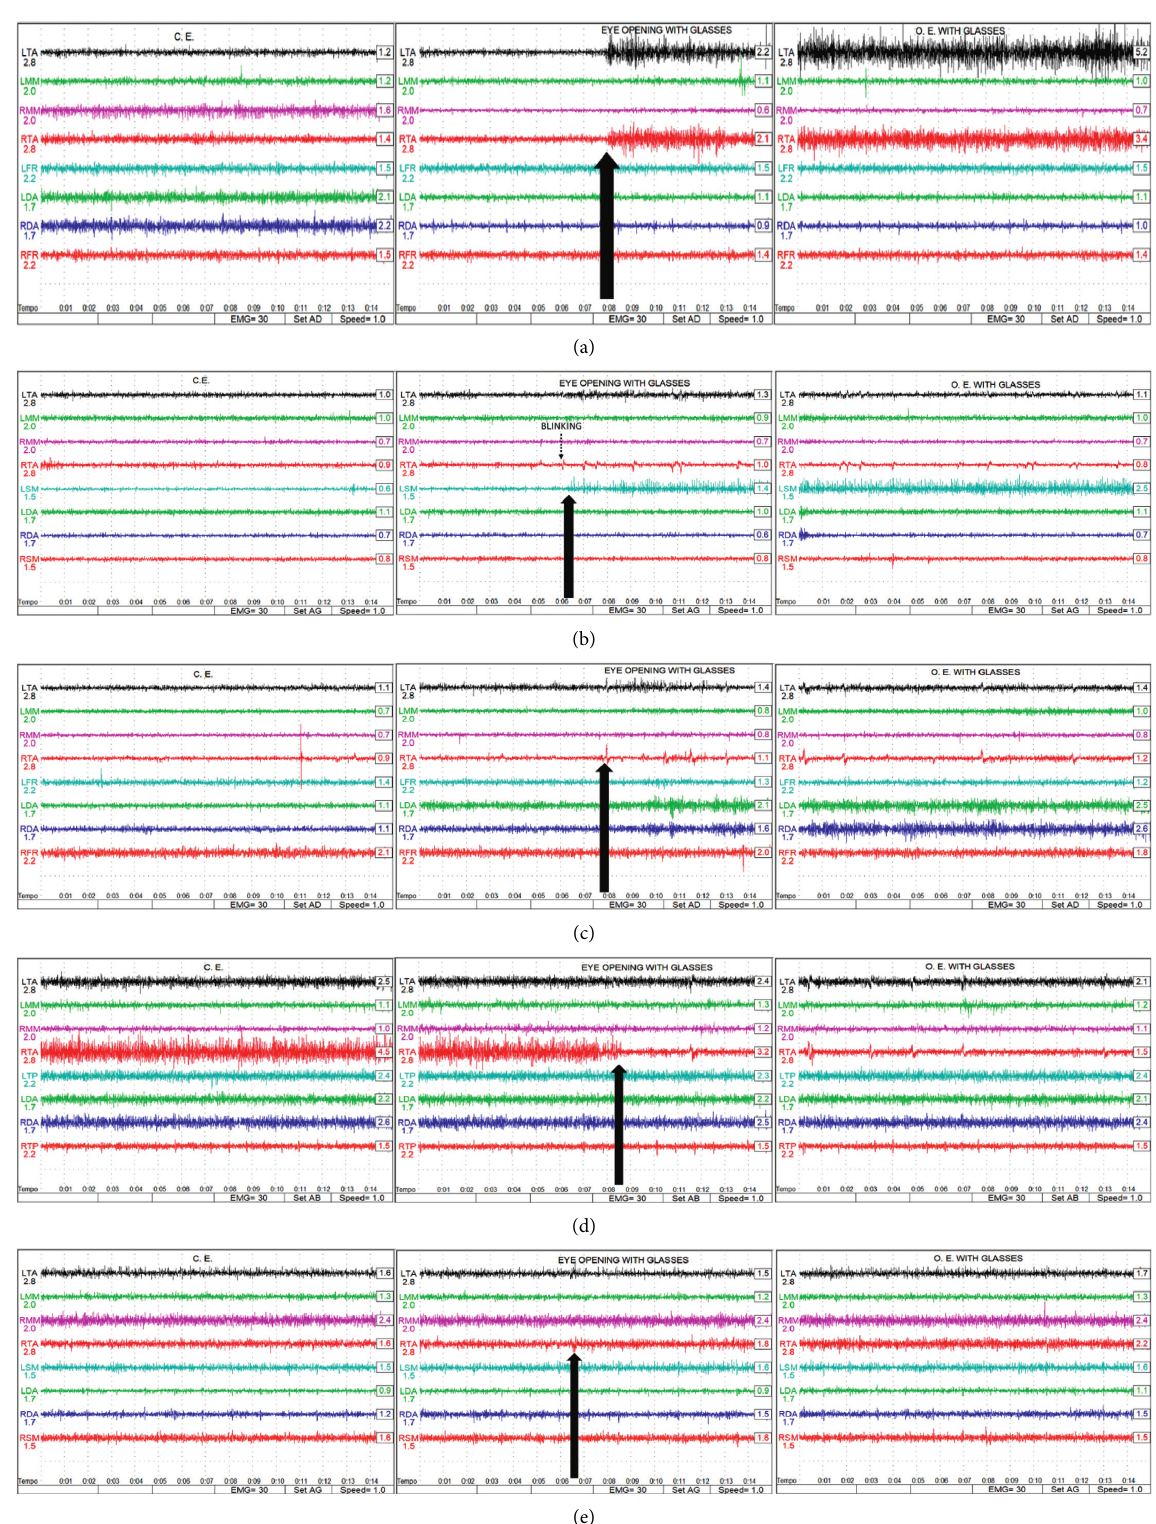
Figure 3: (a–e) Five different cases involving detection of EMG reactions upon opening of the eyes. (a) A trace representing a bilateral increase in an EMG signal from the anterior temporal musculature. (b) A trace representing a monolateral increase in the EMG signal from the left sternocleidomastoid. (c) A trace representing a bilateral increase in the EMG signal from the sovraioidea musculature (anterior abdomen of the digastrics). (d) A trace representing a monolateral decrease in the EMG signal from the RTA. (e) A trace representing the EMG signal from opening of the